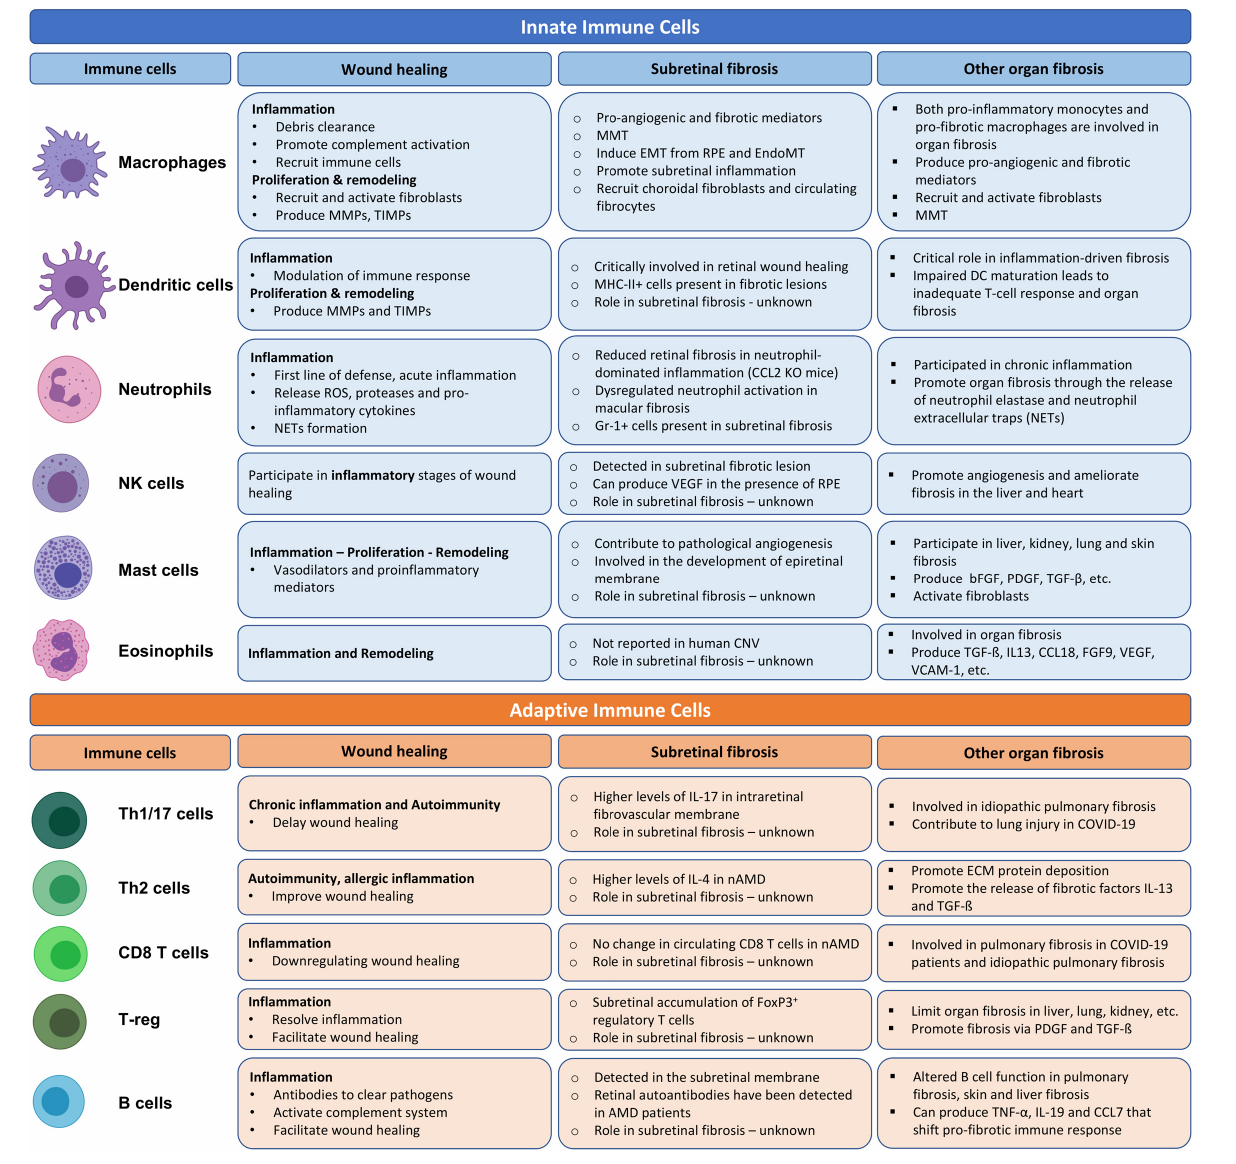
Frontiers in Cellular Neuroscience |